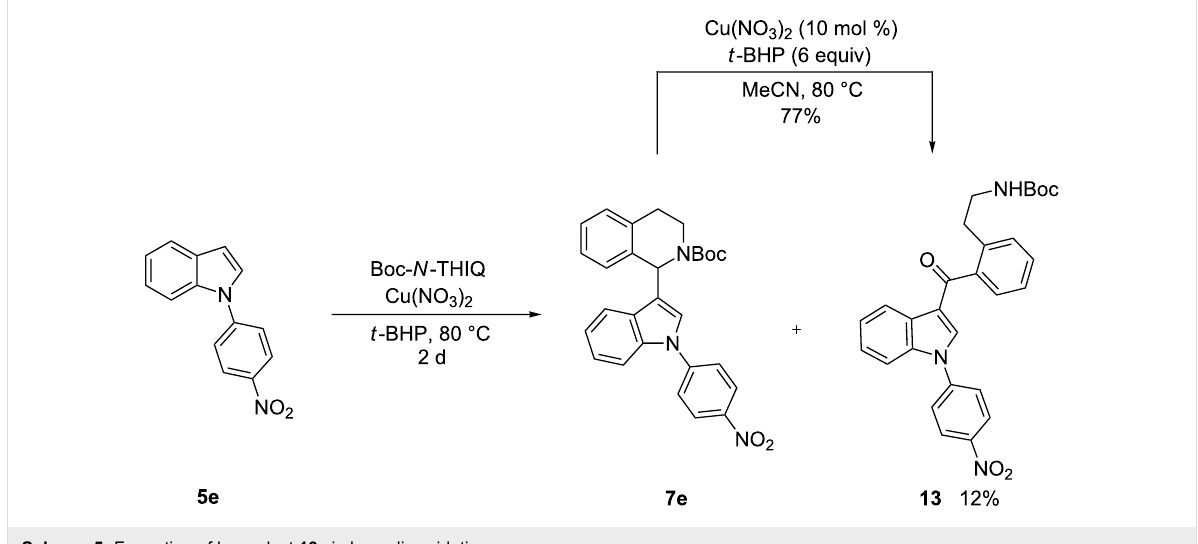
Scheme 5: Formation of byproduct 13 via benzylic oxidation.